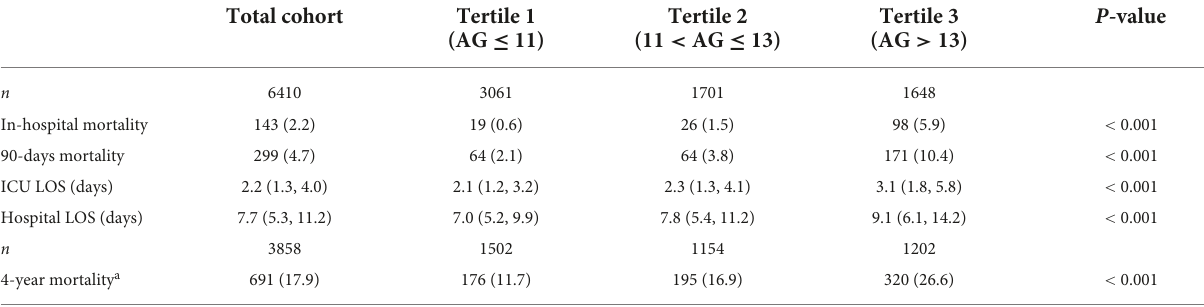
TABLE 2 Outcomes of patients across the tertile of the initial AG.